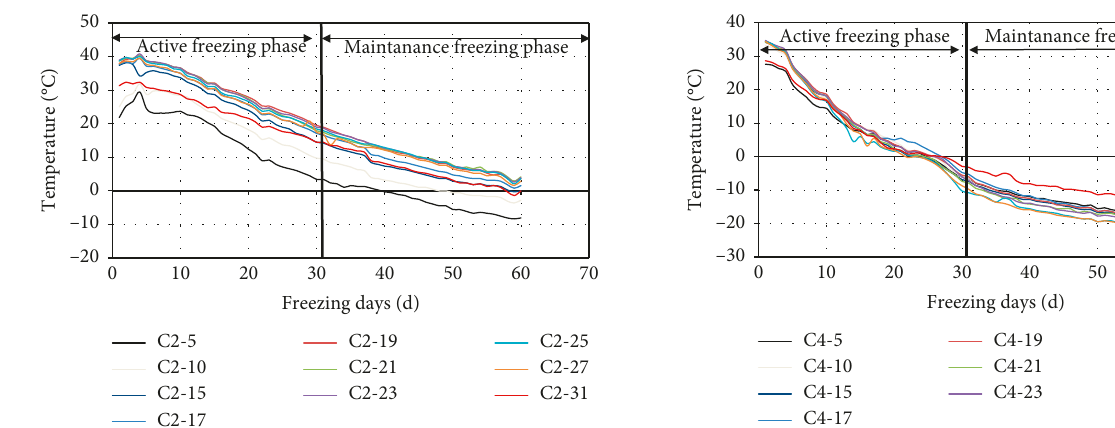
Figure 11: Curves of temperature and times at C4 temperature measuring